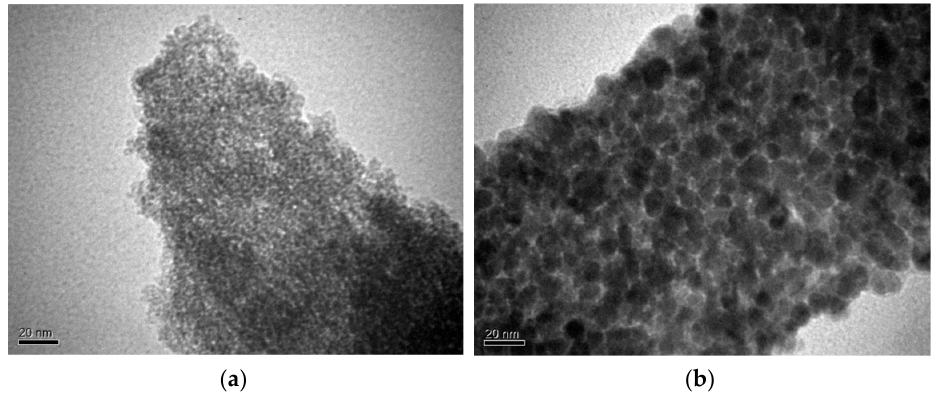
Figure 2. TEM images of ZrO 2 –SiO 2 ( a ) and ZrO 2 –SiO 2 –SnO 2 ( b ).